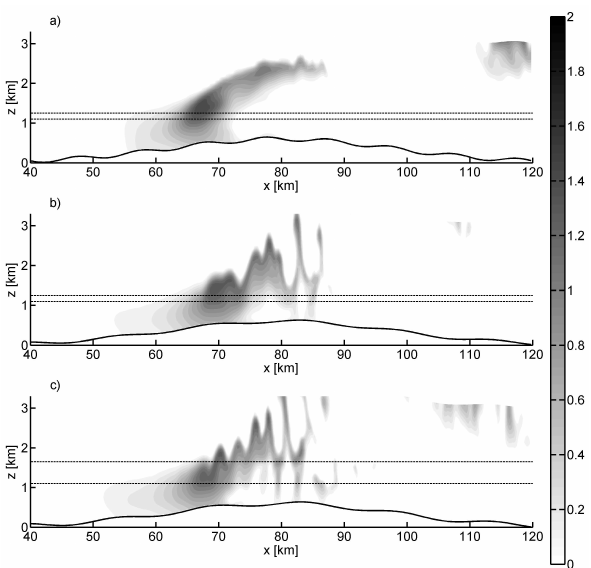
Fig. 8. Cross sections ( xz ) of q c at the y position of its maximum intensity for simulations (a) Sst10km at 04:00h, (b) Sst15km at 04:00h and (c) Sst15km at 05:00h. The solid black line represents topography. The upper and lower black dashed lines represent the levels z q and z = 1100m, c max